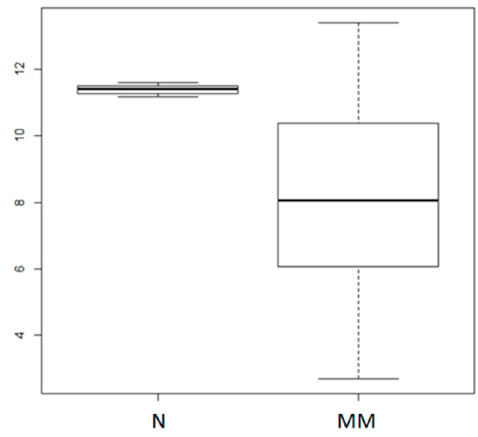
Figure 1. Analysis of miR-155 expression in multiple myeloma primary samples. The miR-155 expression levels in 4 normal donor (N) and 95 primary MM plasma cells (GSE87830); p = 0.01684, as calculated by the Wilcoxon rank sum test. Log2 values of normalized miR-155 expression levels are reported on the y axis.